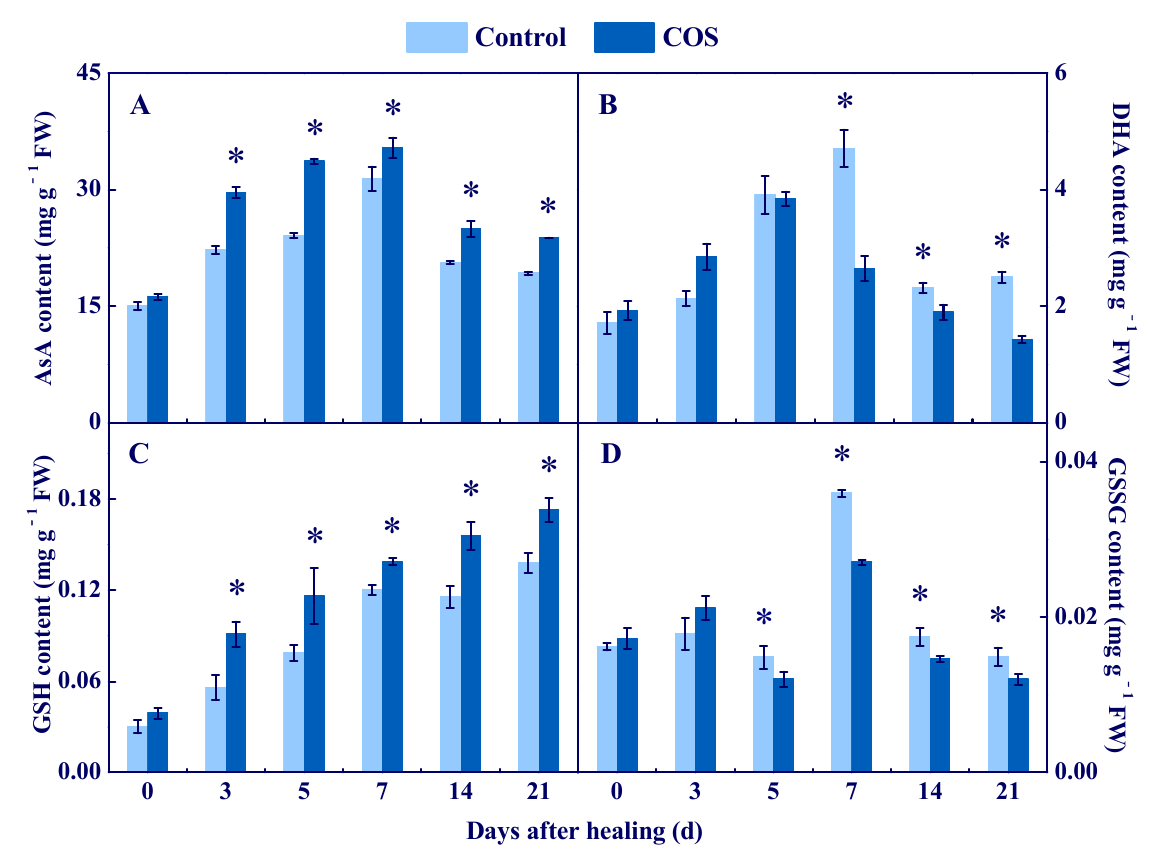
Figure 5. Effect of COS treatment on the contents of AsA ( A ), DHA ( B ), GSH ( C ), and GSSG ( D ) at wounds of potato tubers during healing. Bars indicate standard error. Asterisks denote significant differences ( p < 0.05).